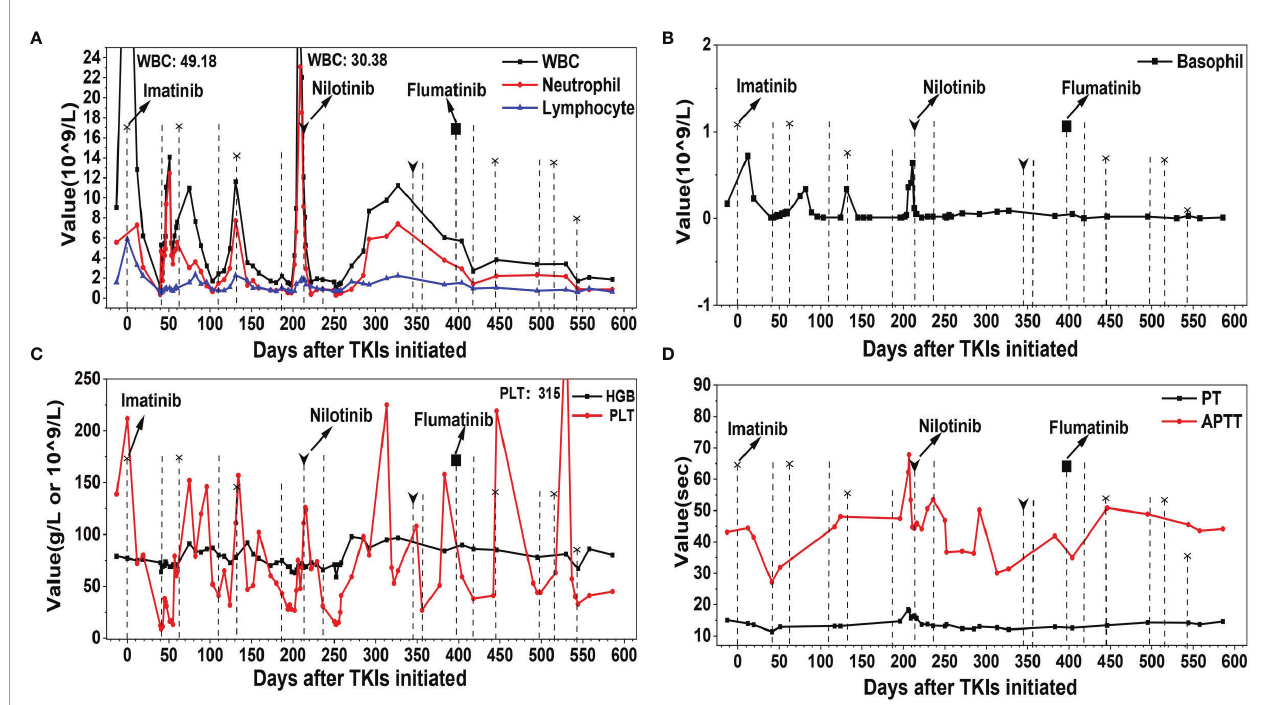
FIGURE 2 | The pro fi le of white blood cell (WBC), hemoglobin (HGB), platelet (PLT), prothrombin time (PT), and activated partial thromboplastin time (APTT) of the patient during the therapy course of tyrosine kinase inhibitors (TKIs). (A) WBC, neutrophil, and lymphocyte. (B) Basophil. (C) HGB and PLT. (D) PT and APTT. Dotted line with and without head indicate the initiation and stopping of TKI, respectively. The shape of the heads indicates the type of